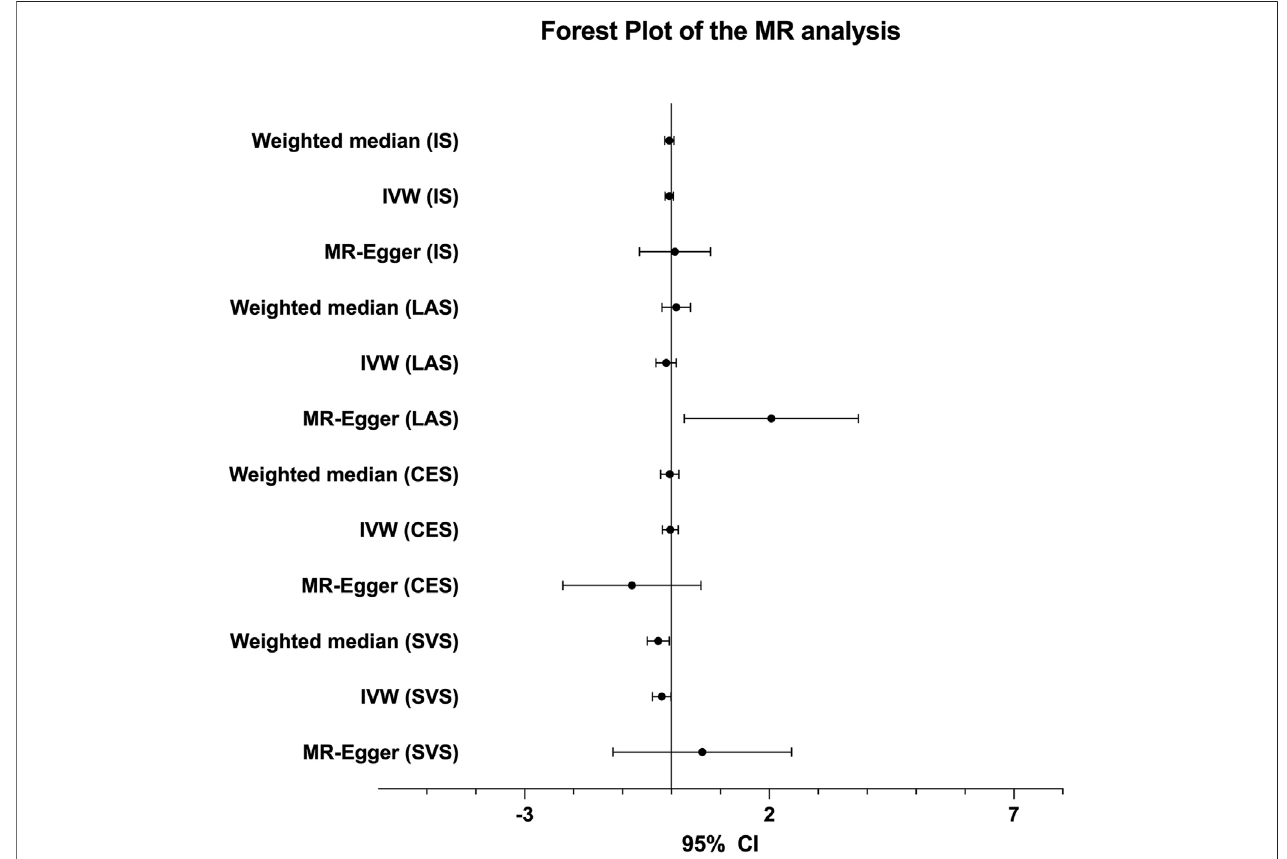
FIGURE 3 | The forest plot of the MR